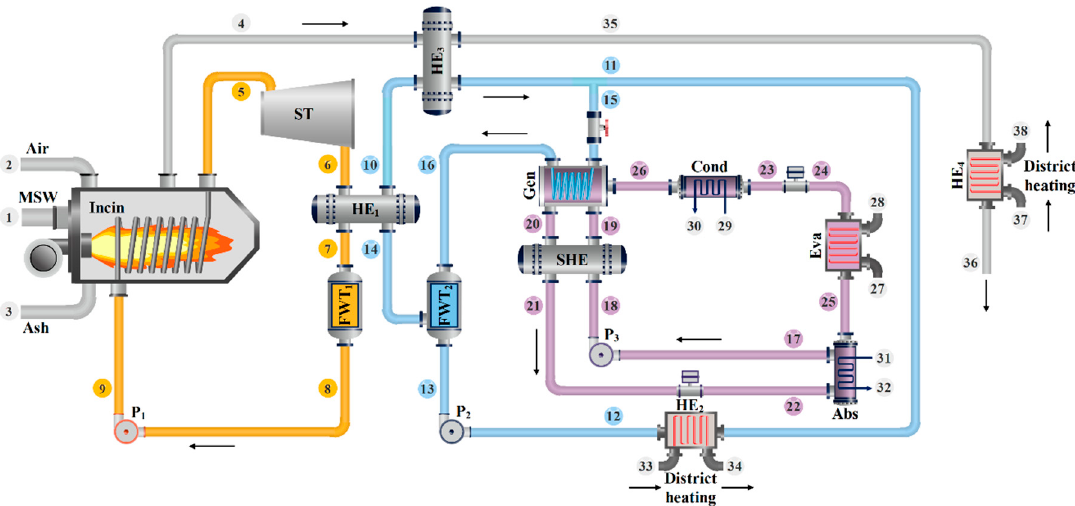
Figure 1. Flow diagram of the proposed municipal waste-fired CCHP (MSW: municipal solid waste; Incin: incinerator; P: pump; ST: steam turbine; FWT: feed water tank; HE: heat exchanger; SHE: solution heat exchanger; Abs: absorber; Gen: generator; Eva: